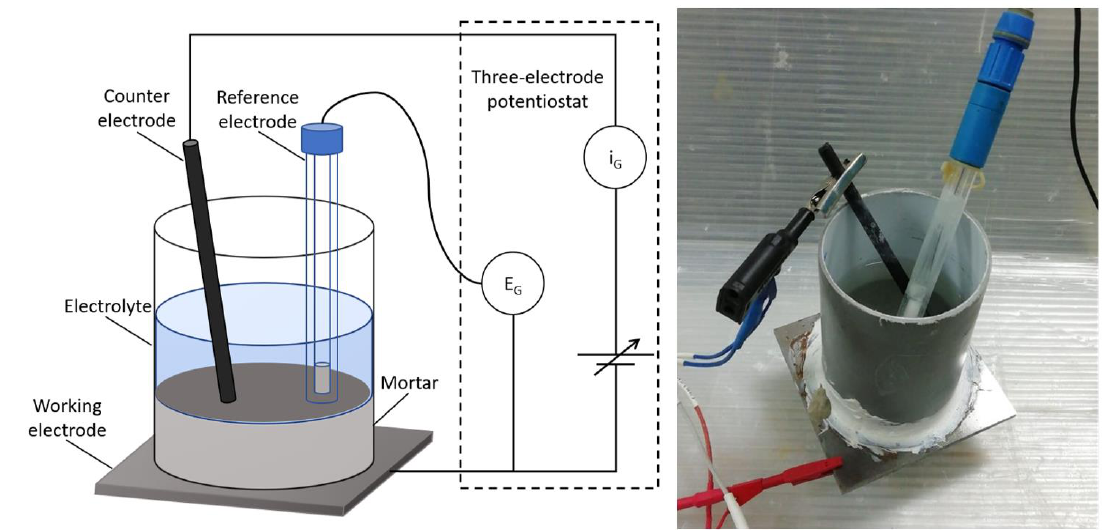
Figure 1. Schematic representation of the three-electrode cell.